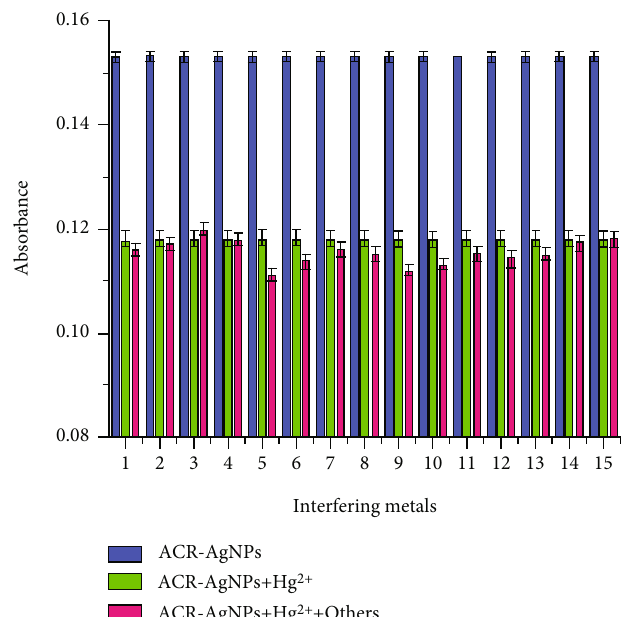
Figure 7: Consequence of competing metal ions on the sensing performance of ACR-AgNPs for Hg 2+ , in the presence of 1: NH 4+ , 2: Mn 2+ , 3: Ni 2+ , 4: Ba 2+ , 5: Mg 2+ , 6: Cr 3+ , 7: Pb 2+ , 8: Pd 2+ , 9: Al 3+ , 10: Sn 2+ , 11: Fe 2+ , 12: Co 2+ , 13: Cu 2+ , 14: Fe 3+ , and 15: Cd 2+ at 410 nm.